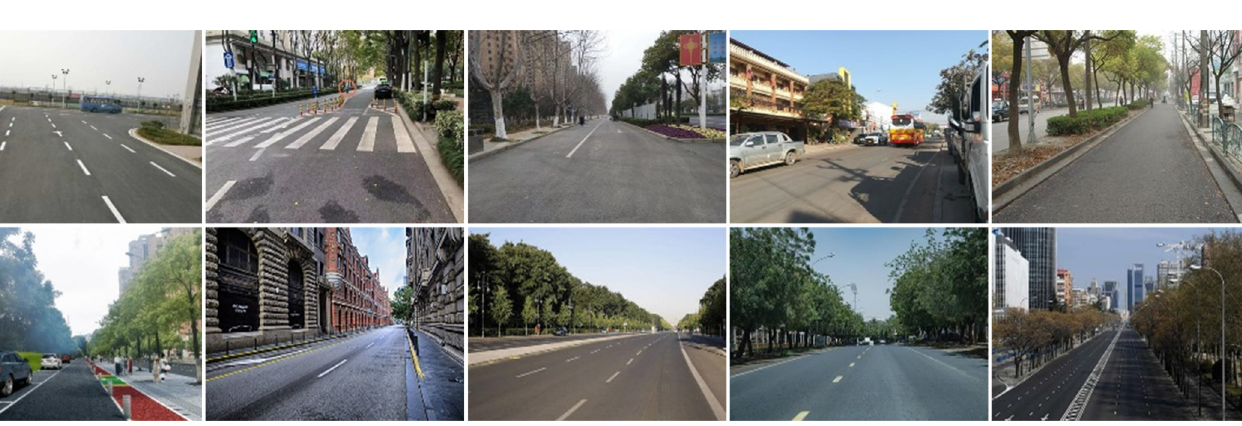
Figure 9. Data augmentation. 3.2. Case 2: Waterlogging Recognition for Actual Scenarios 3.2.1. Experimental Setup Fuzhou, the capital of Fujian Province, is located on the southeastern coast of China (26°08 ′ N, 119°28 ′ E). In the experiment, a camera was installed at an overpass above (Figure 10) the road and aimed at the over fl owing municipal pipe network inspection well to ob- tain a video stream. The picture resolution was 2560 × 1440, with 96 dots per inch, and the frame rate of the camera was 25 frames per second. Figure 10. The experimental setup.